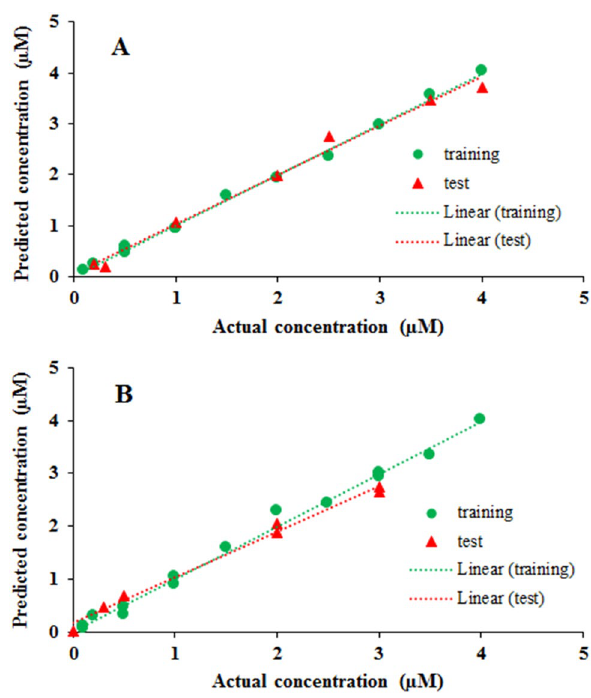
Figure 9. Results of Calibration and validation by PLS model for ( A ) MOR and ( B ) MET.